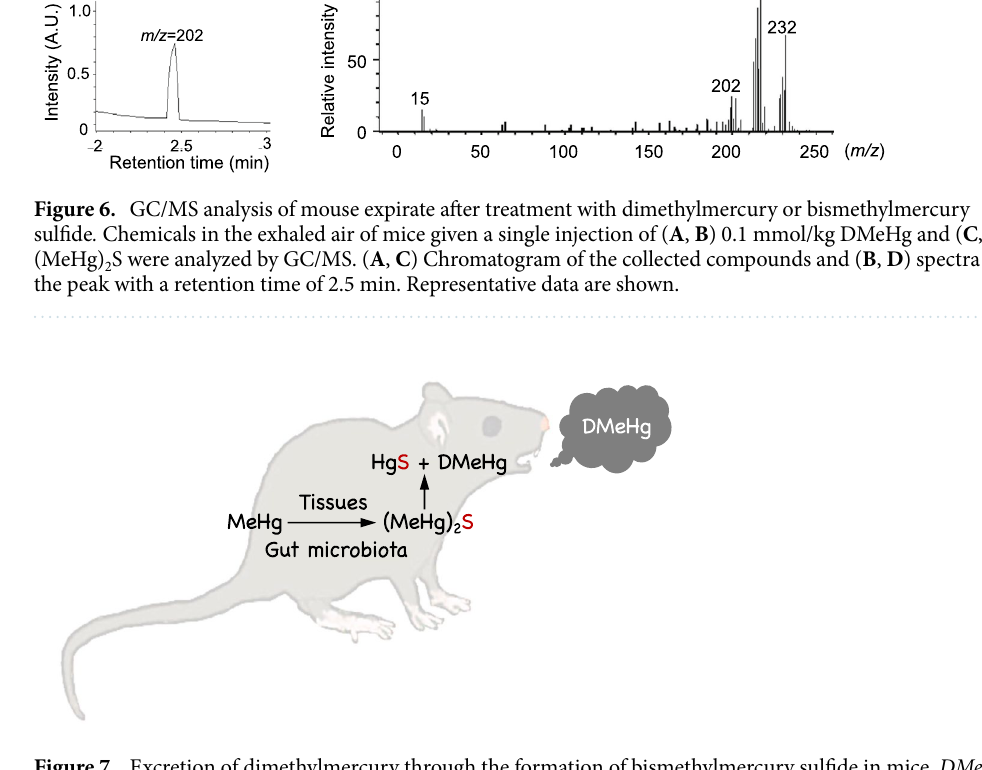
Figure 7. Excretion of dimethylmercury through the formation of bismethylmercury sulfide in mice. DMeHg dimethylmercury, MeHg methylmercury, (MeHg) 2 S bismethylmercury sulfide. MeHg was transformed into (MeHg) 2 S via reaction with reactive sulfur species in tissue and intestine. A portion of intestinal (MeHg) 2 S might be absorbed into the body. (MeHg) 2 S slowly decomposed to HgS and DMeHg, which could be excreted from the